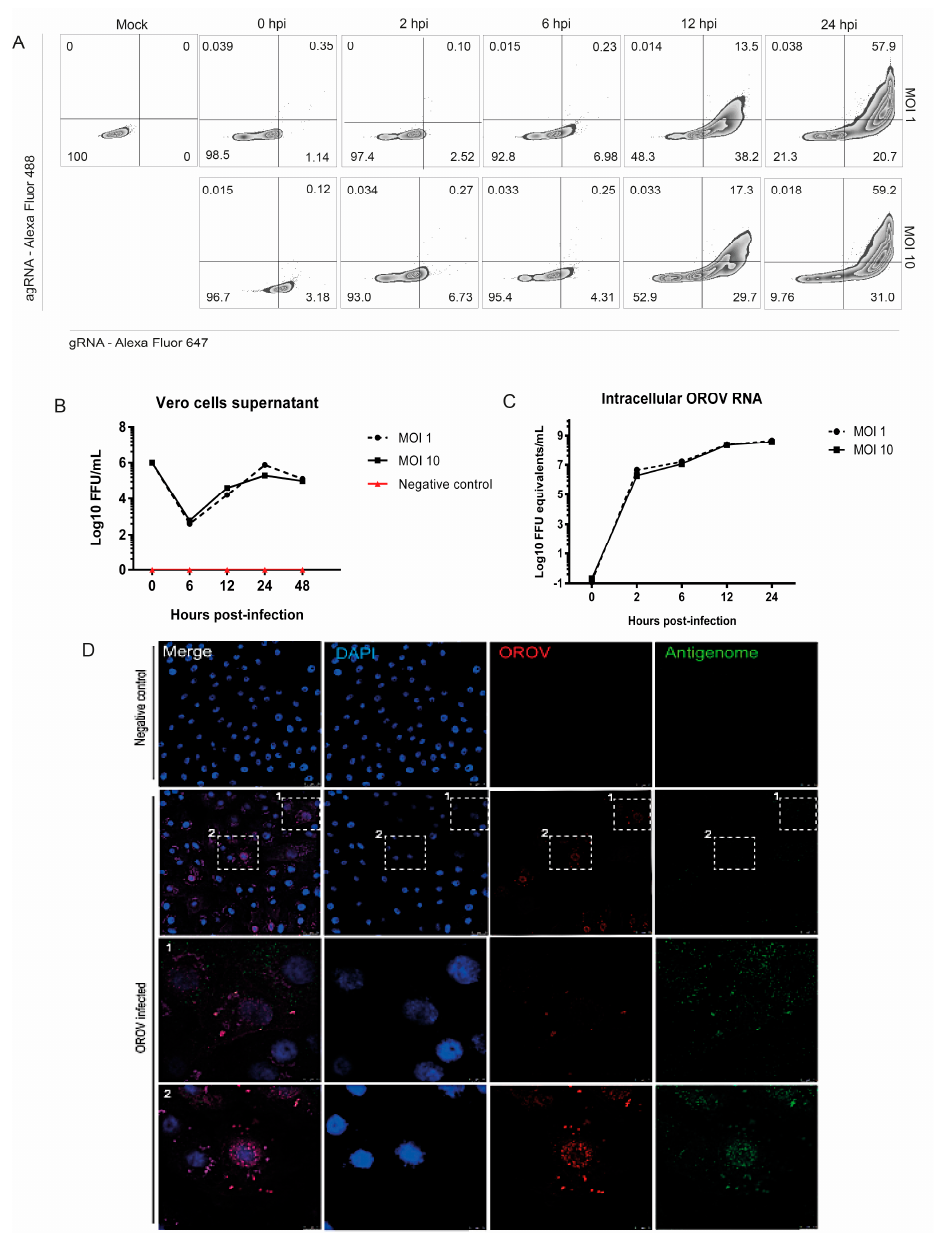
Figure 1. OROV genome and antigenome detection in Vero cells. RNA PrimeFlow ™ assay for the detection of OROV productive infection was standardized in Vero cells. ( A ) Vero cells were previously infected with OROV and analyzed by RNA PrimeFlow ™ assay at 2, 6, 12 and 24 hpi. Quadrants exhibit OROV genome (gRNA), antigenome (agRNA) or both detection in Vero cells infected at a Multiplicity of Infection (MOI) 1 and 10, and the percentage of events. Noninfected cells were also submitted to the protocol and are shown as the mock sample. ( B ) Vero cells were infected with OROV at MOI 1 and 10. Supernatants were collected at 0, 2, 6, 12, 24, and 48 hpi, and analyzed by focus forming assay (FFA). ( C ) Lysates from cellular monolayers were collected and analyzed by qRT-PCR for the assessment of OROV RNA. ( D ) Vero cells were cultivated in coverslips and infected with MOI 2. At 18 h post-infection, the coverslips were submitted to RNA PrimeFlow ™ protocol for immunofluorescence. It is shown OROV proteins in red (Alexa Fluor 594), antigenome in green (AlexaFluor 488) and cell nuclei in blue (DAPI). Images with 63x times magnification. Scales at 2 µ m, with 10 µ m in zoomed